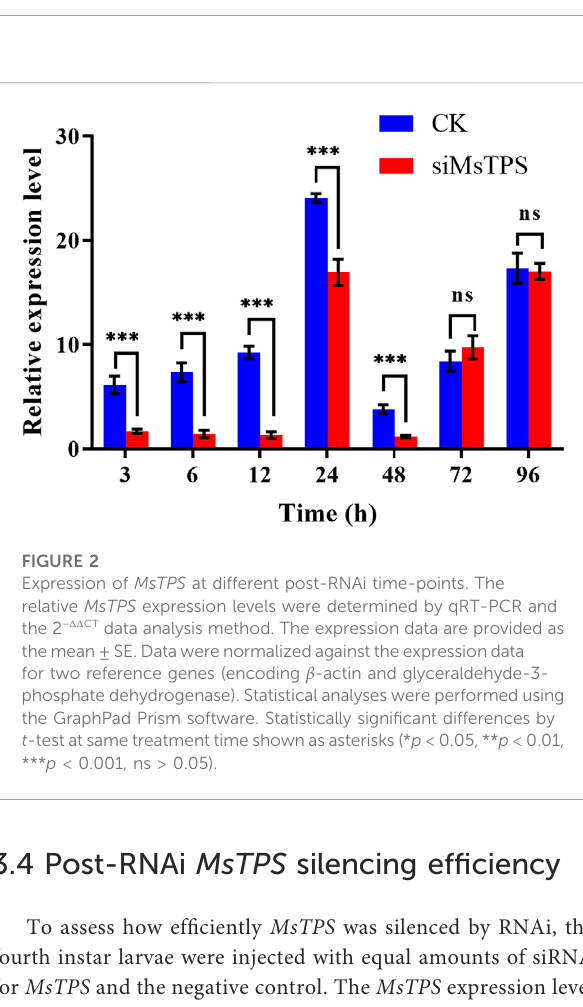
FIGURE 1 Spatiotemporal MsTPS expression pattern in different developmental stages (A) and in diverse tissues (B) of M. separata . The qRT-PCR data for MsTPS wereanalyzedusingthe2 − ΔΔ CT methodtodeterminerelativeexpressionlevels,whichwerecalculatedasthemean±SE.Theexpressiondatawere normalized on the basis of the geometric mean of the expression of two reference genes (encoding β -actin and glyceraldehyde-3-phosphate dehydrogenase).TheGraphPadPrismsoftwarewasusedforthedataanalysis.Differentlettersindicatesigni fi cantdifferences( p < 0.05)accordingto the Tukey ’ s test.